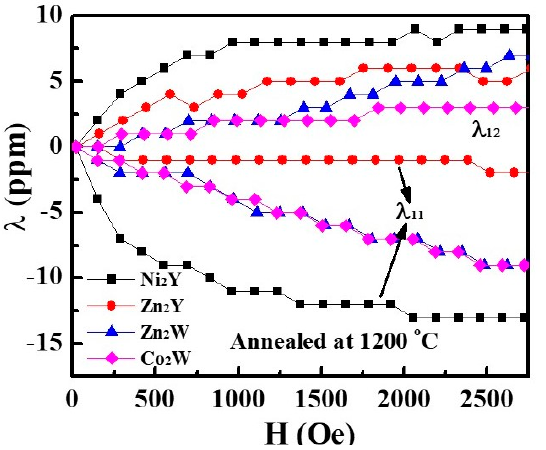
Figure 5. Parallel magnetostriction λ 11 and perpendicular magnetostriction λ 12 vs. H data measured in a disc of fibers of Y- and W-type hexagonal ferrites.